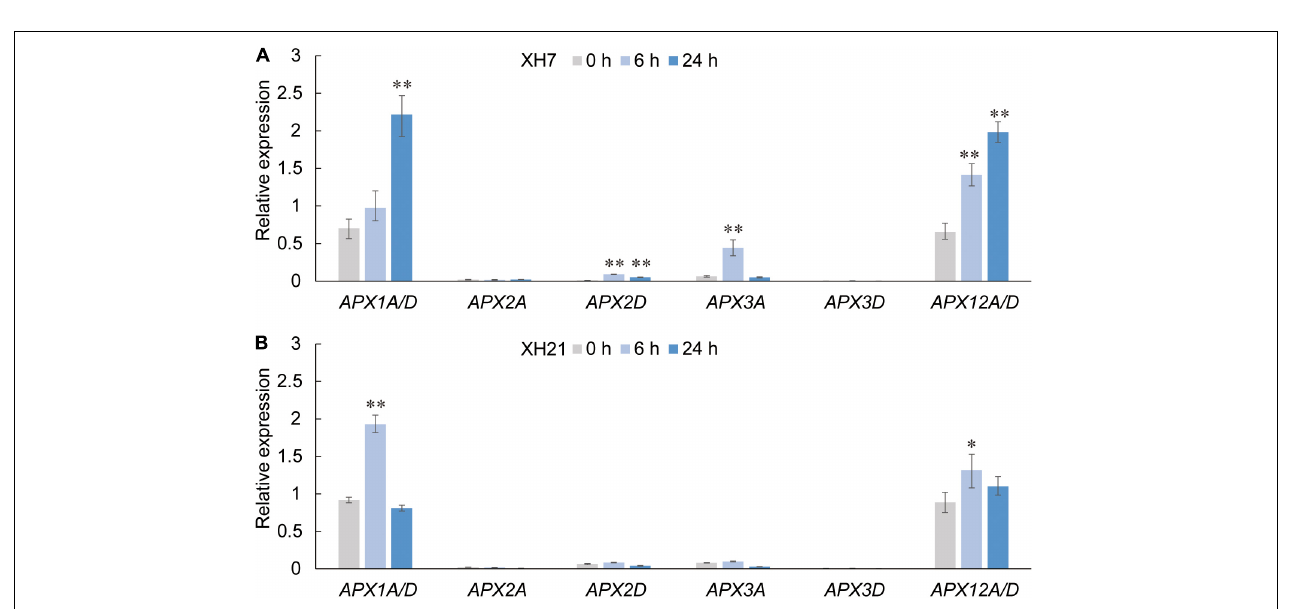
FIGURE 4 | Relative expression levels of APX family members in Pima cotton roots of XH7 (A) and XH21 (B) at 0, 6, and 24 h after V. dahliae incubation. Genes with extremely high nucleotide similarity that could not be distinguished by primers were detected using identical primers ( APX1A/D and APX12A/D ). GbUBQ was used as a reference gene and set to 1. Three independent replicates were performed for each qPCR assay. Significance was analyzed using one-Way ANOVA. ∗ p < 0.05; ∗∗ p < 0.01.